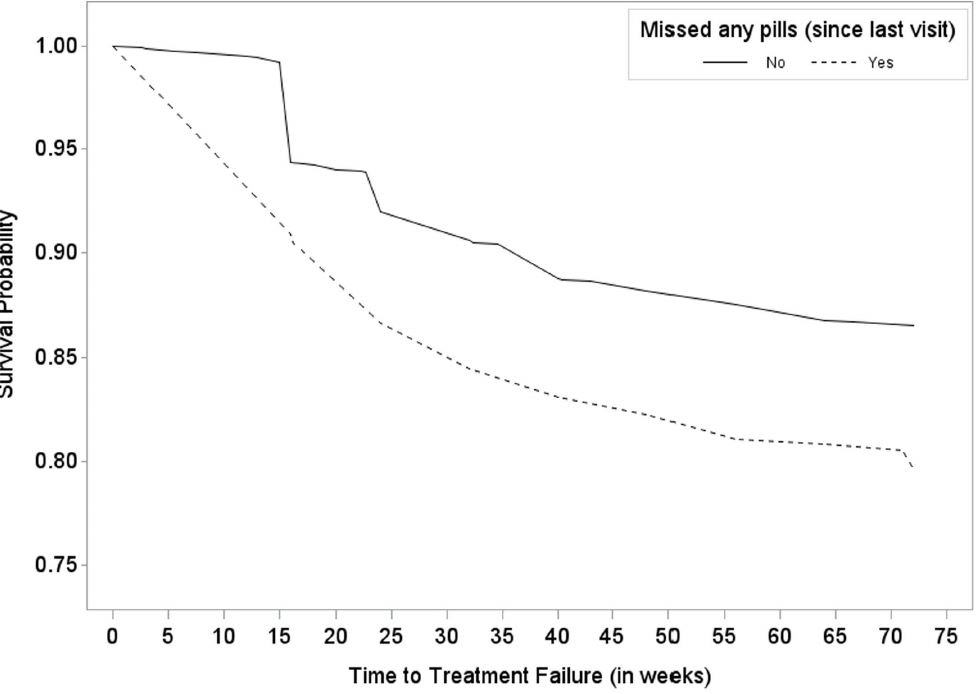
Figure 1. ACTG A5175/Pearls trial – Survival probability estimate from randomization to treatment failure by pill count non- adherence (solid line = did not miss any pills; dashed line = missed any pills).